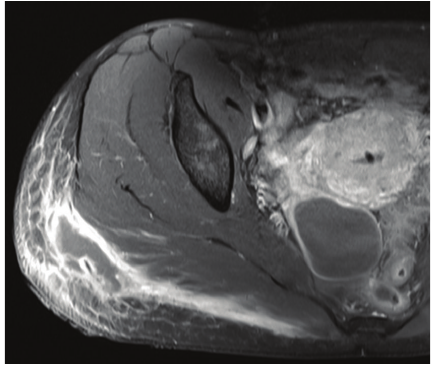
Figure 1: MRI shows T1 phase with gadolinium contrast, showing a small superficial gluteal collection joining large deep subcutaneous collections in contact with the muscular fascia, associated with diffuse infiltration of the neighbouring subcutaneous tissue and the gluteus maximus muscles.